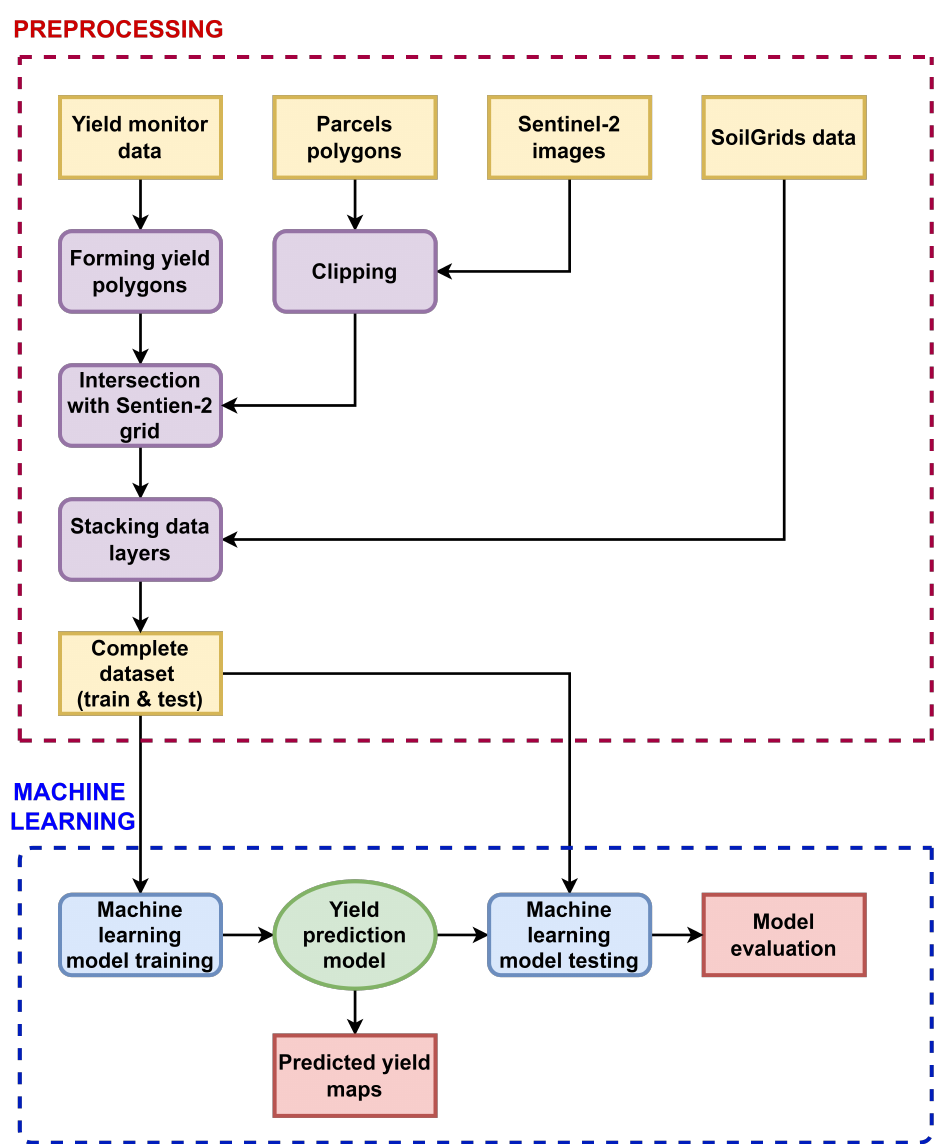
Figure 1. A flowchart overview and example walk-through of the methods presented in this paper. Datasets are shown in yellow, purple denotes the preprocessing operations, and modules for ML are shown in blue, while the resulting model and outputs (prediction maps and model performance) are shown in green and red, respectively. Black arrows indicate the flow of data. The segments belonging to the preprocessing part are framed by a red dashed line, while the ML components are bordered by blue dashed